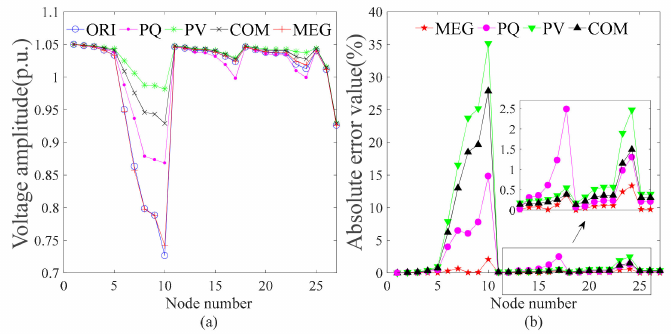
Figure 7. Static simulation result of the internal system in Scenario 1. ( a ) Voltage amplitude. ( b ) Equivalent errors of four